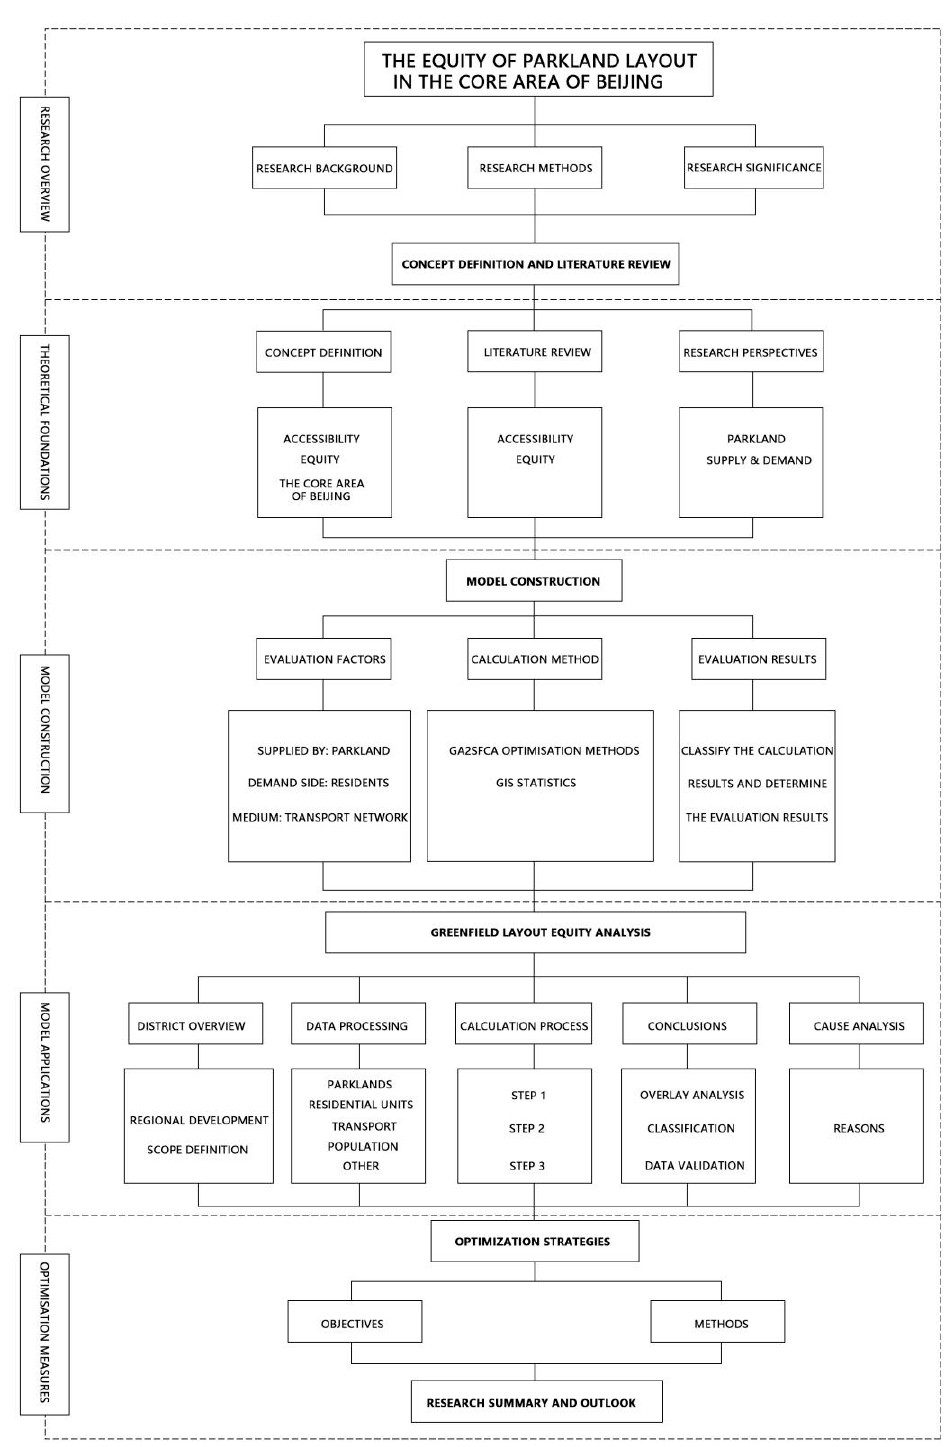
Figure A1. Technical framework for the research.